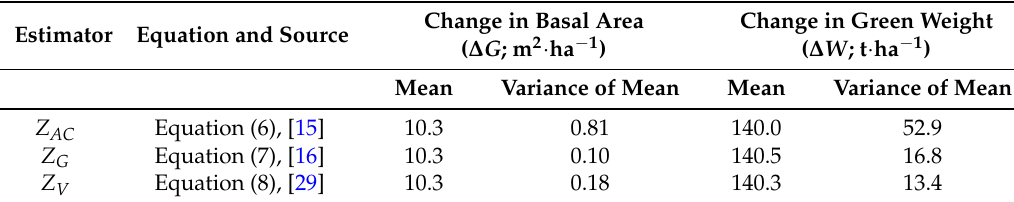
Table 3. Estimates and efficiencies of the point sampling change estimators obtained for basal area and green weight per ha in Brazil.